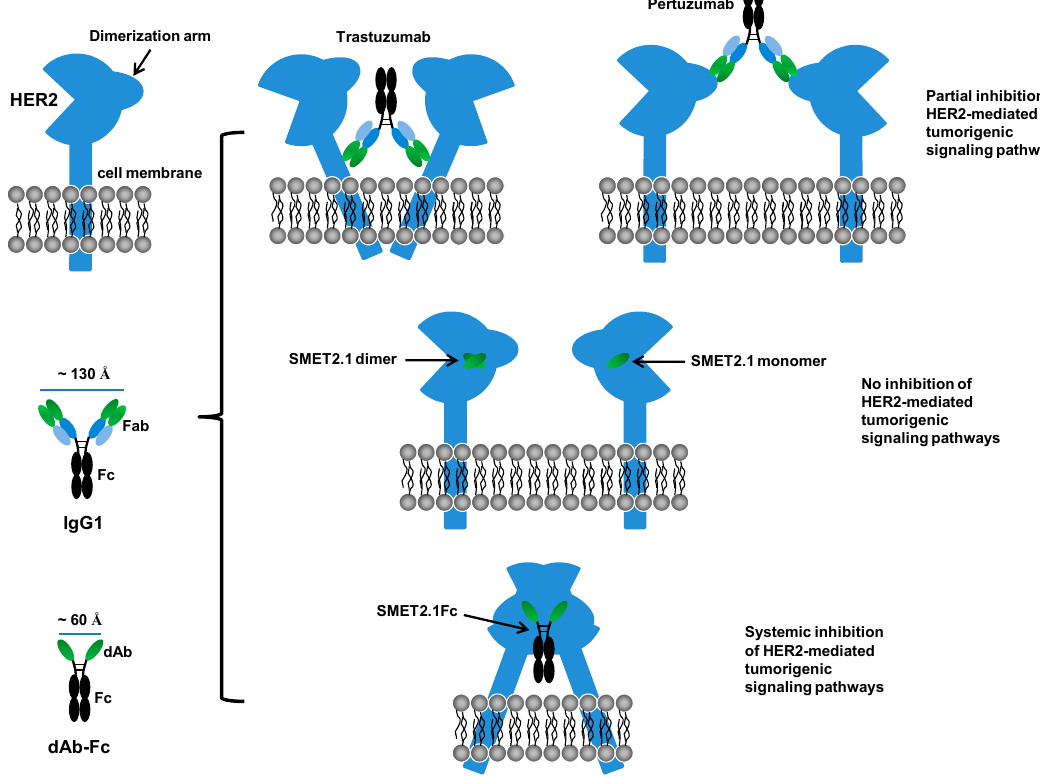
Figure 7. A potential molecular mechanism for potent inhibitory activity of SMET2.1Fc against HER2-overexpressing human breast cancer cells. The distance between antigen-binding sites of an IgG1 or a dAb-Fc fusion protein is estimated by using a published IgG1 crystal structure (Protein Data Bank entry 1HZH) as a template and the Measurement tool of the PyMOL molecular graphics system (version 1.5.0.4; Schrödinger, LLC).